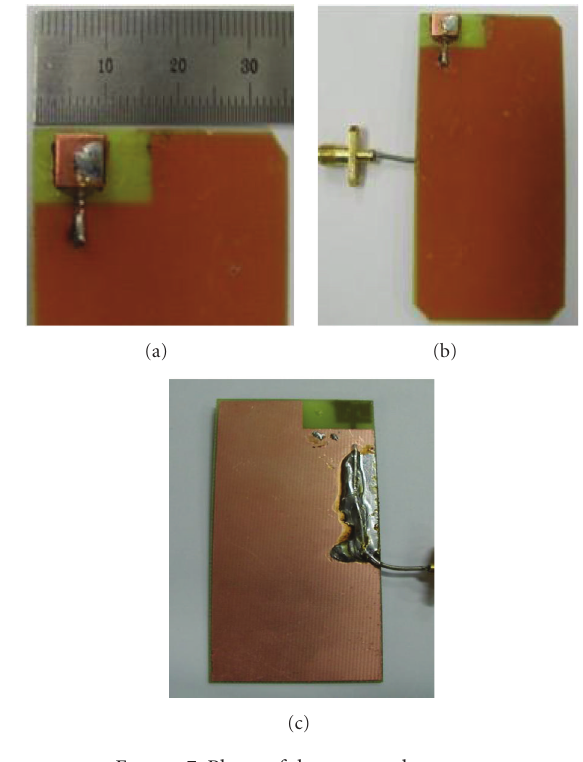
Figure 7: Photo of the proposed antenna.